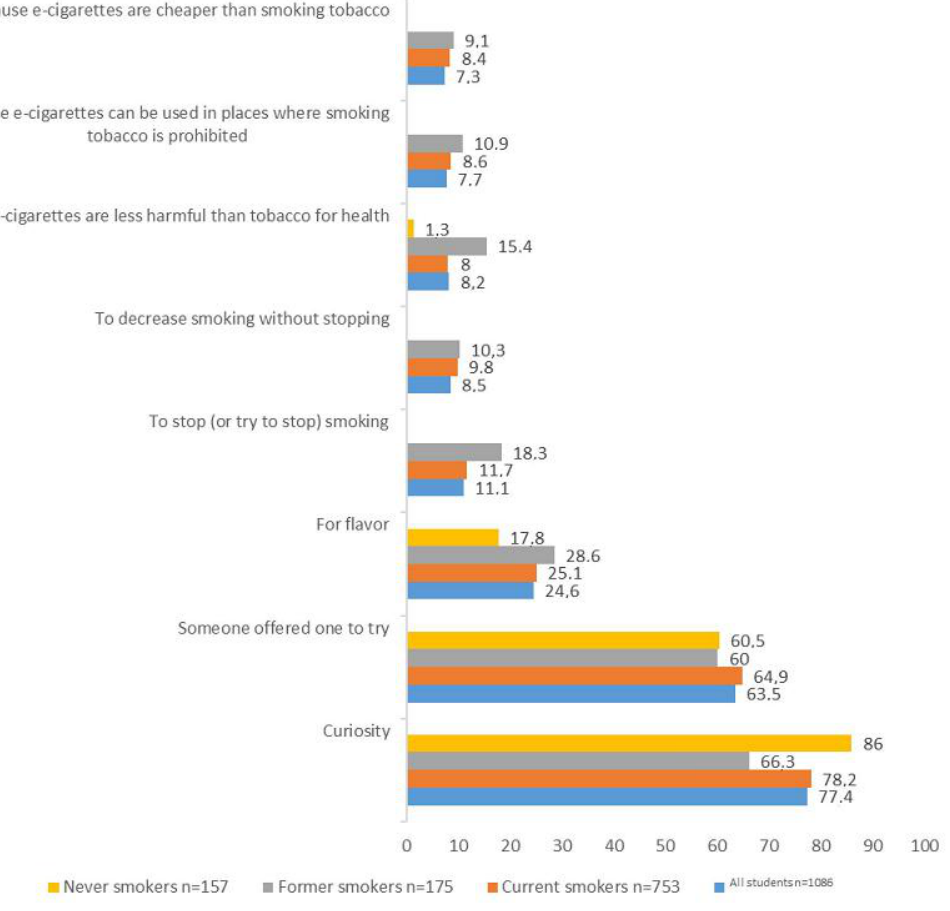
Figure 2. Reasons for trying e-cigarette (overall and according to smoking status) among students who had tried it. Missing data on smoking status, n = 1. Smoking status: current smokers were those smoking occasionally (less than once a day) or daily at time of survey. Former smokers were those who did not smoke at time of